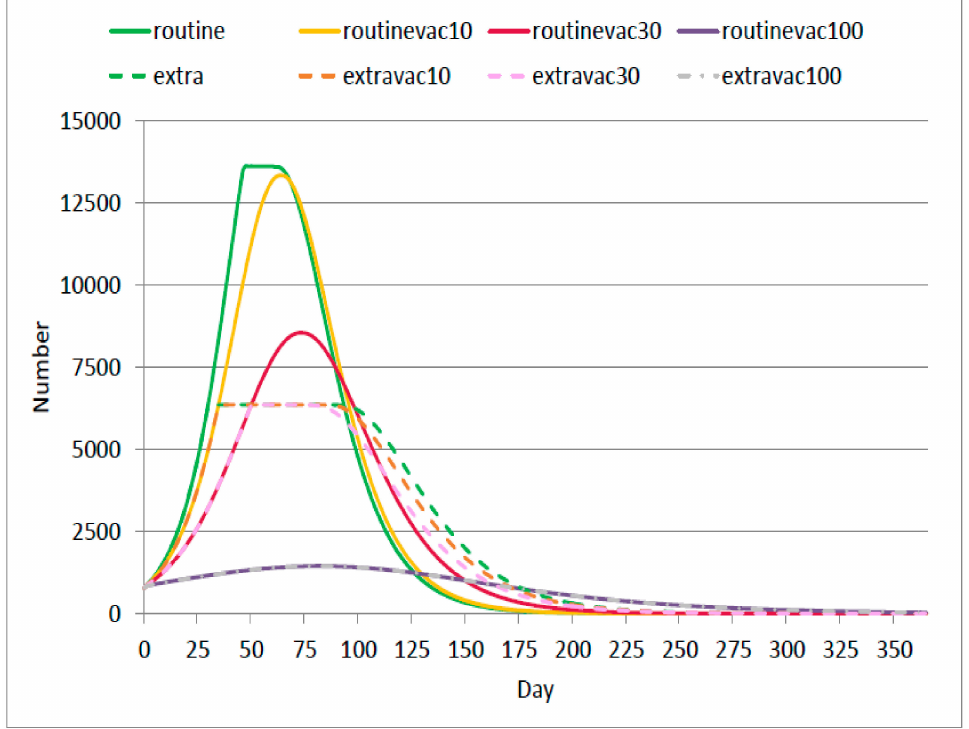
Figure 2. Number of infected cases at any point of time in a year in di ff erent